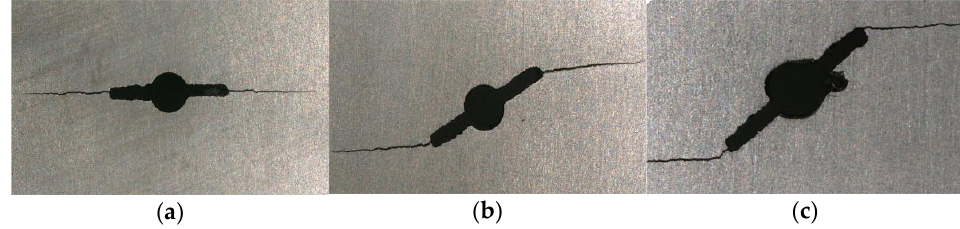
Figure 5. Photos for propagation path under crack inclination angles 90°, 60° and 45°. ( a ) β = 90°, λ = 0.5, R = 0.1. ( b ) β = 60°, λ = 0.5, R = 0.1. ( c ) β = 45°, λ = 0.5, R = 0.1.